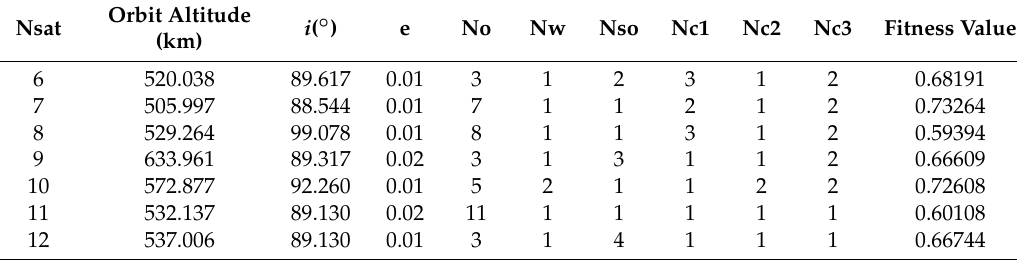
Table 5. The parameters of the optimal 3D-LFC configurations.